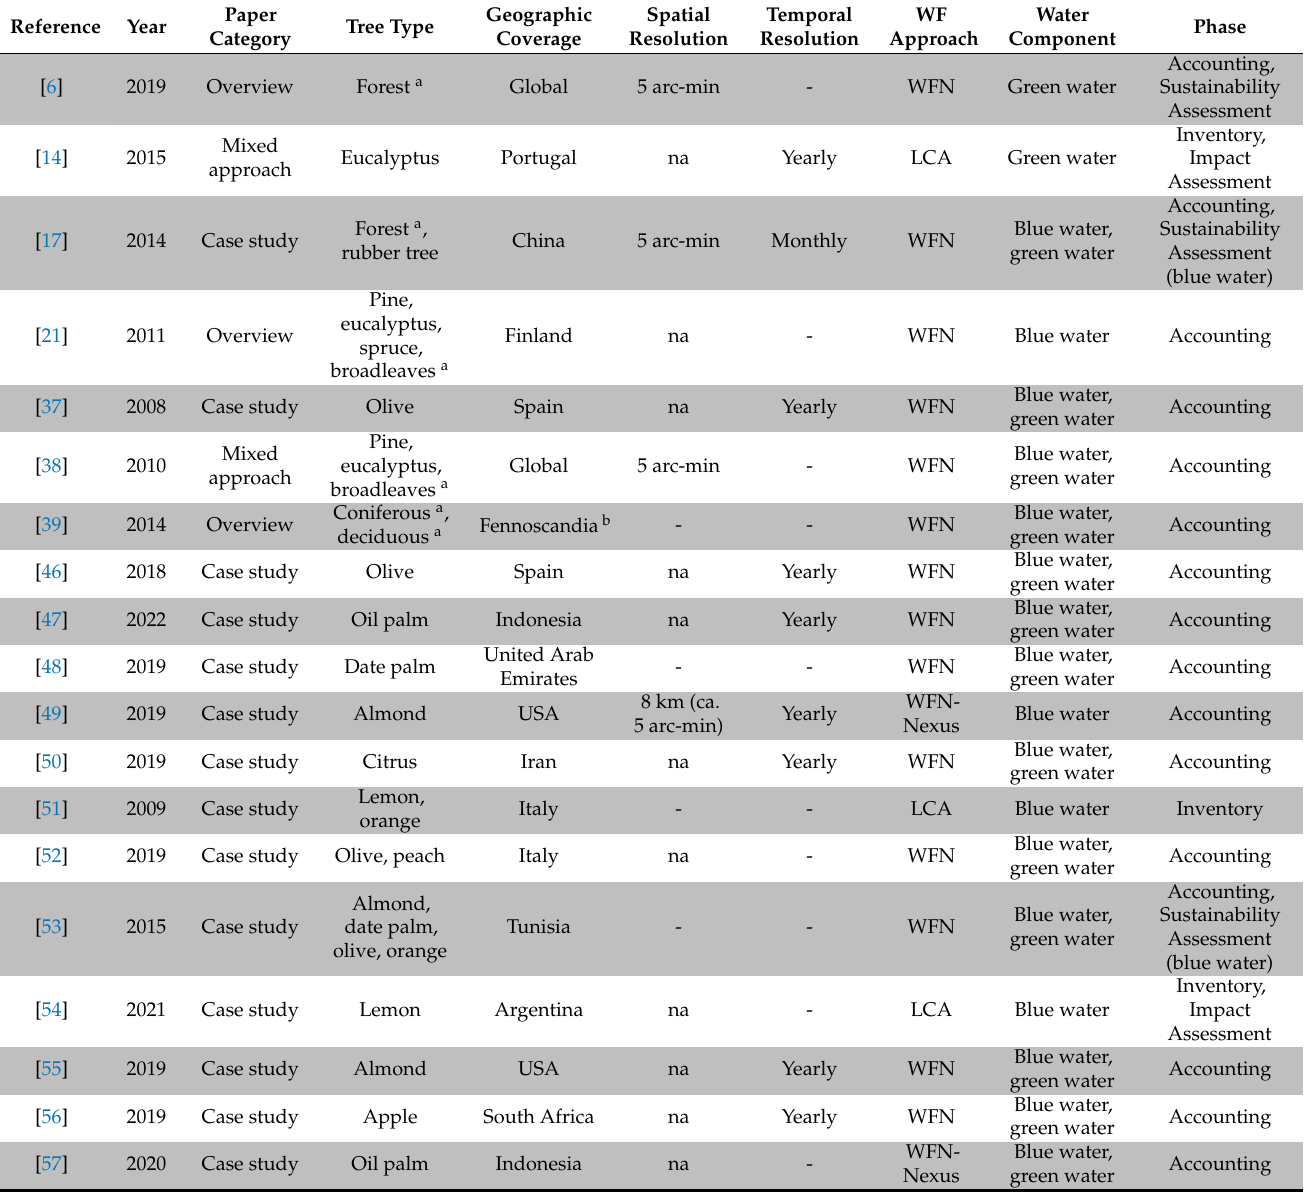
Table 1. Key information of the literature